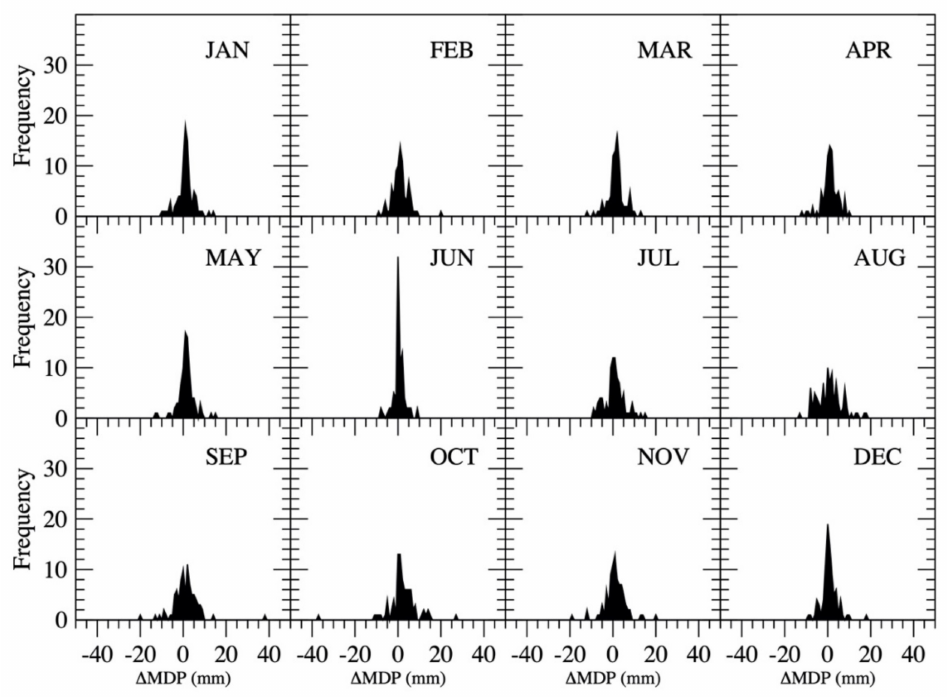
Figure 12. Probability distribution of each month’s ∆